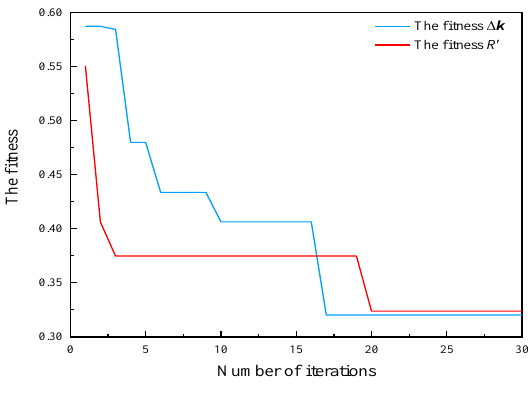
Figure 11. The fitness curve.